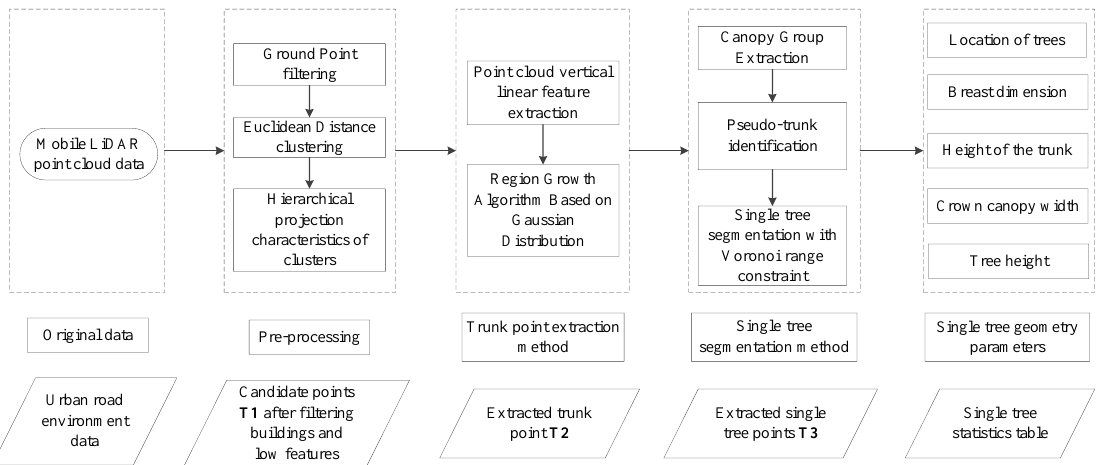
Figure 1. Flow chart of street tree extraction from mobile LiDAR data.